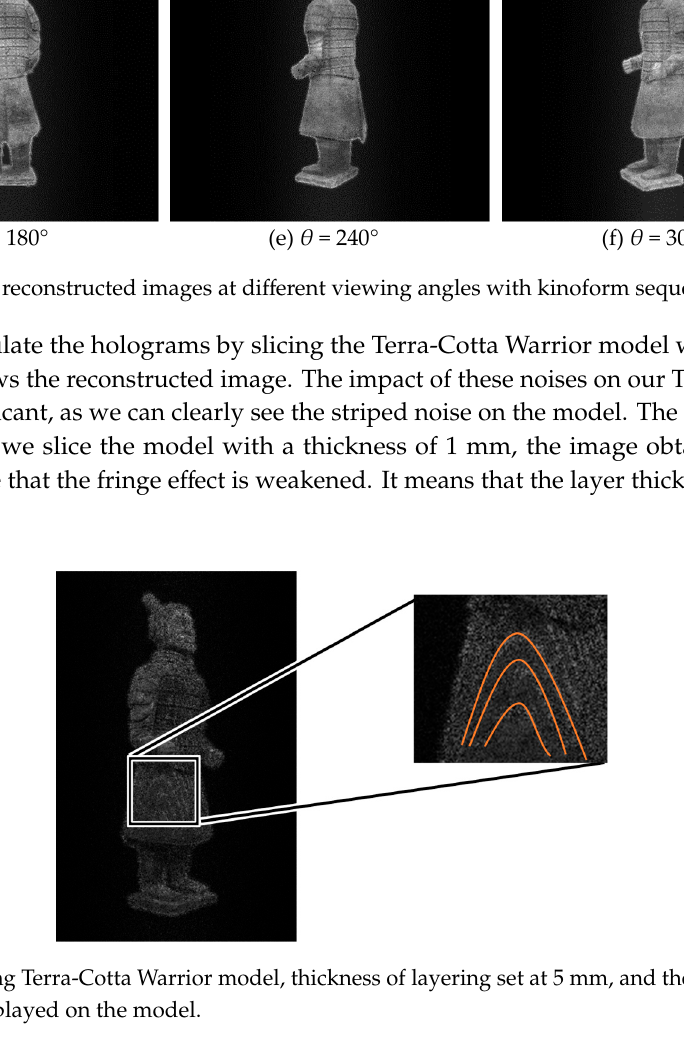
Figure 8. Layering Terra-Cotta Warrior model, thickness of layering set at 1 mm.